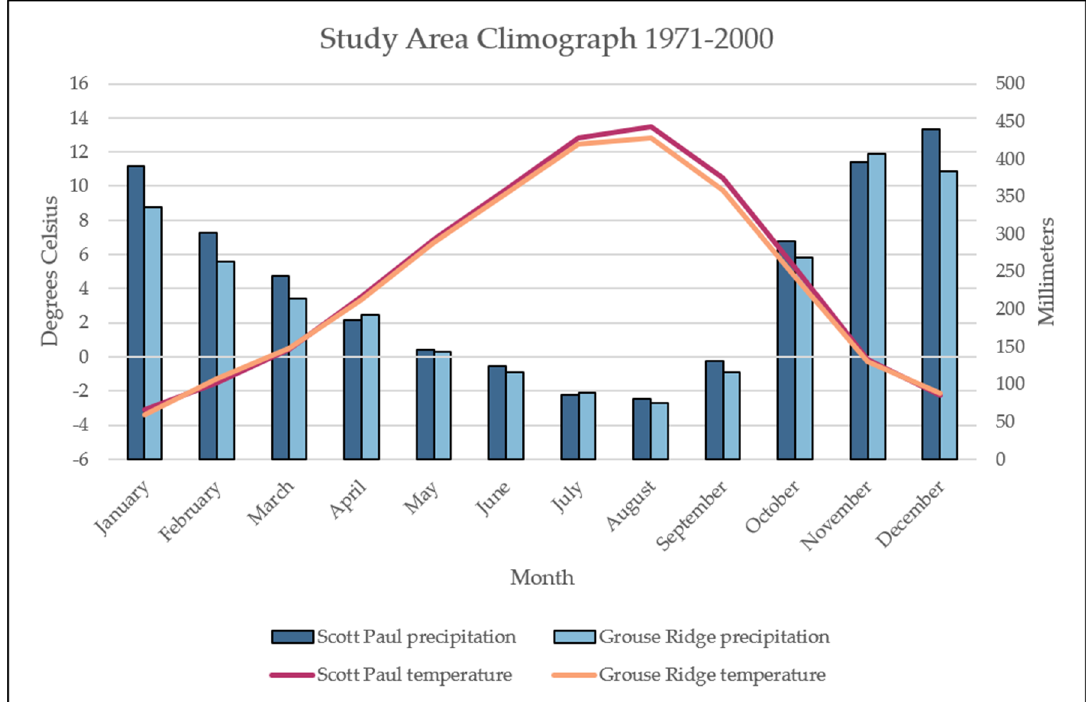
Figure 2. Climograph with precipitation and temperature for both the Scott Paul and Grouse Ridge site. Trees and other plants growing in the subalpine ecotone are adapted to these cold, wet winter conditions and relatively young soils. The most common tree species at our sites are mountain hemlock ( Tsuga mertensiana ), Pacific silver fir ( Abies amabilis ), and, at the Grouse Ridge site, Alaskan yellow cedar ( Callitropsis nootkatensis ). Pacific silver